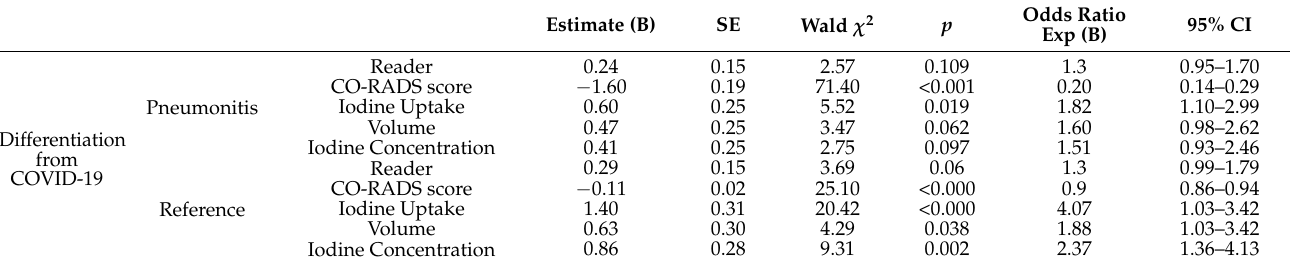
Table 3. Multinomial regression results, COVID-19 = reference